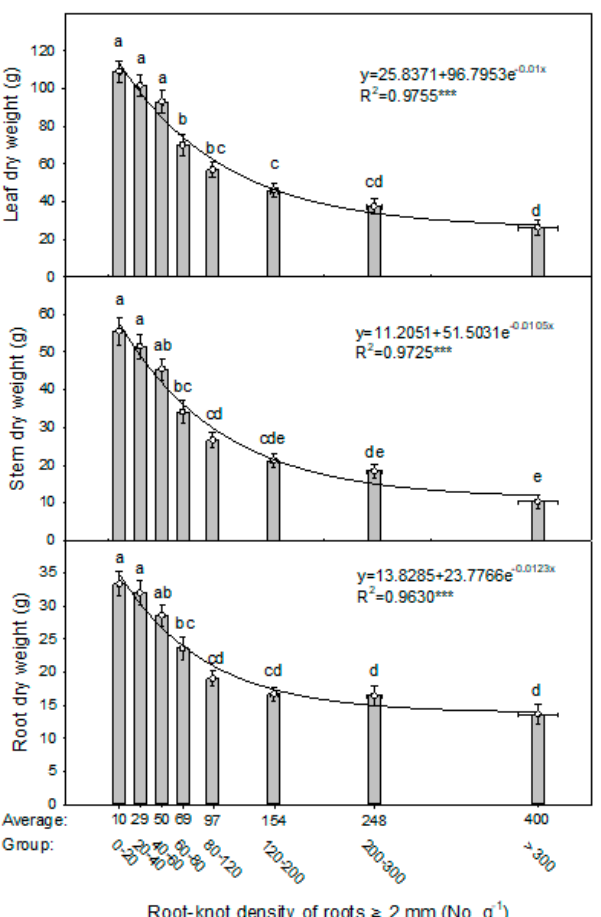
Figure 6. Average root-knot density of roots with a root diameter ≥ 2 mm and their relationship with the average leaf dry weight, stem dry weight, and root dry weight in corrected groups based on RKD reclassification. Different lowercase letters represent significant difference at p = 0.05. Significant level: ***, p < 0.001.